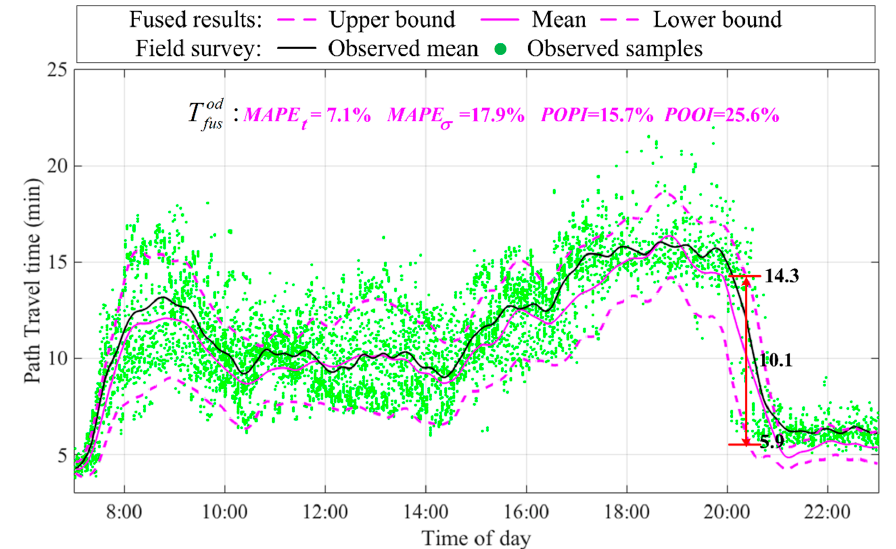
Figure 6. Fused path travel time distribution during the period of interest.